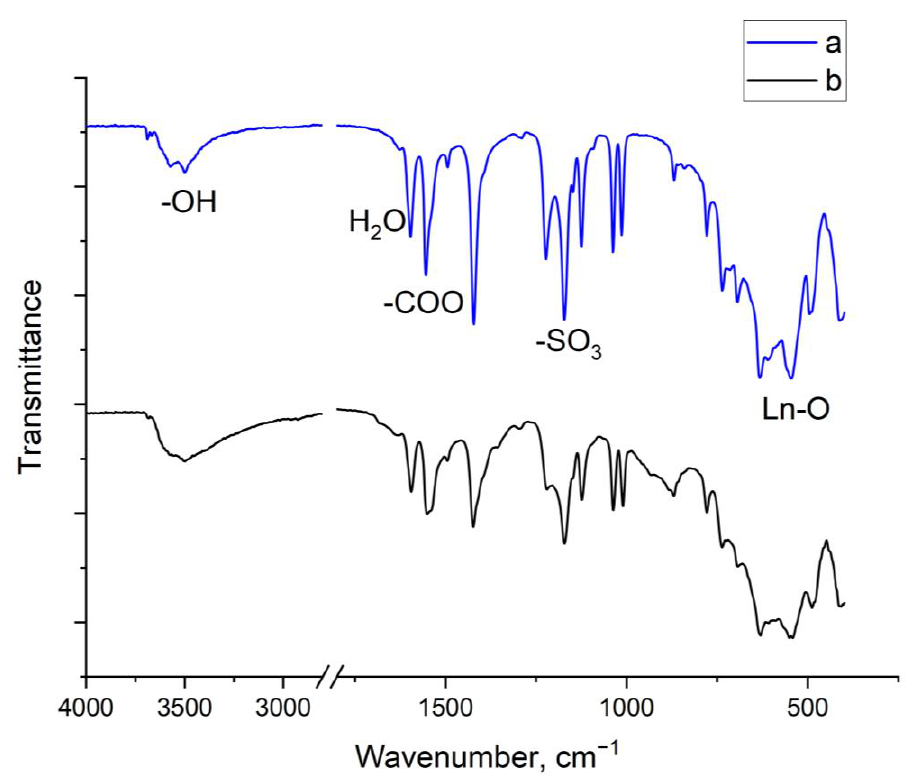
Figure 4. IR spectra of (a) (Gd 0.38 Eu 0.04 Tb 0.58 ) 3 (OH) 7 (C 7 H 4 O 5 S) · n H 2 O, obtained by the one-step synthesis, and (b) (Gd 0.16 Eu 0.02 Tb 0.82 ) 2 (OH) 5.1 (C 7 H 4 O 5 S) 0.45 · n H 2 O, obtained by high-temperature ion exchange.